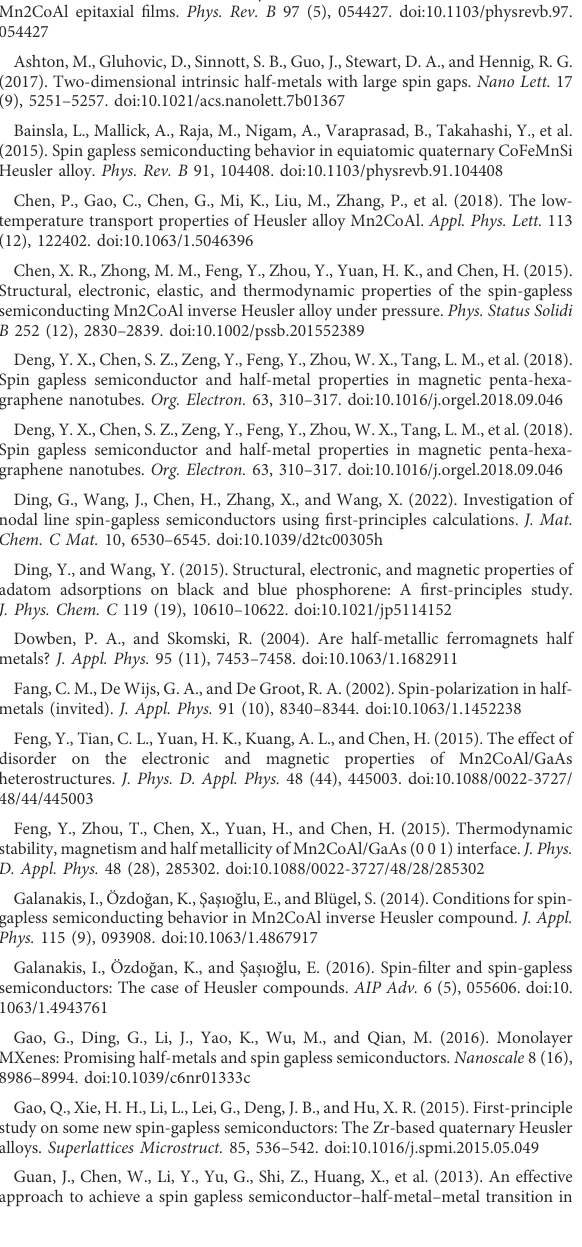
zigzag graphene nanoribbons: Attaching A fl oating induced dipole fi eld via π – π interactions. Adv. Funct. Mat. 23 (12), 1507 – 1518.